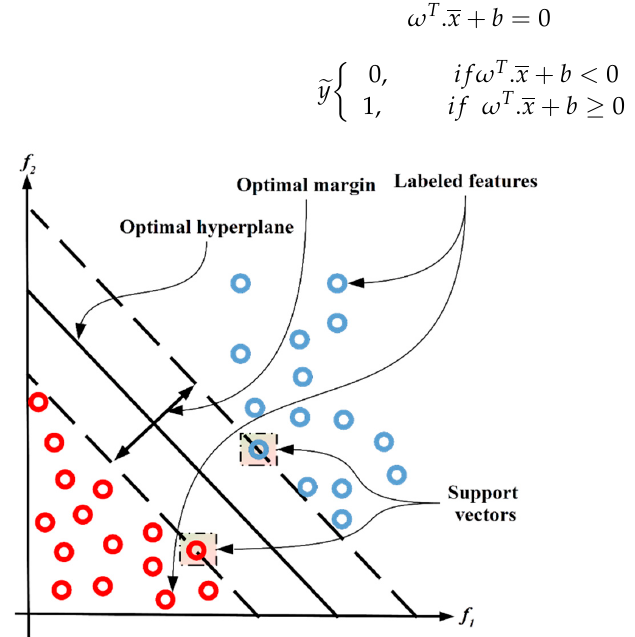
Figure 7. Local binary pattern (LBP) conversion process where ( a ) is the RGB satellite image, ( b ) is the gray level image, and ( c ) is the LBP image.